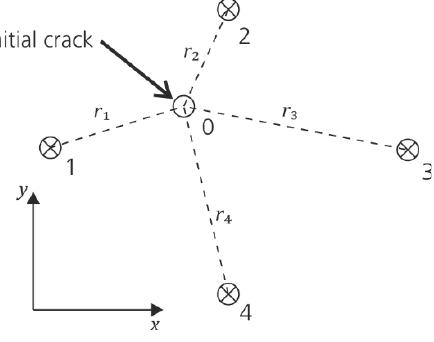
Fig. 9 Situation of initial cracking, related measurement and used